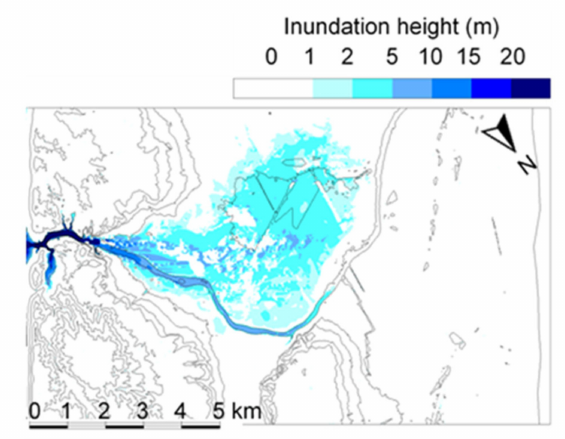
Figure 25. (Case–2). Inundation height, 30 min after start of the calculation.